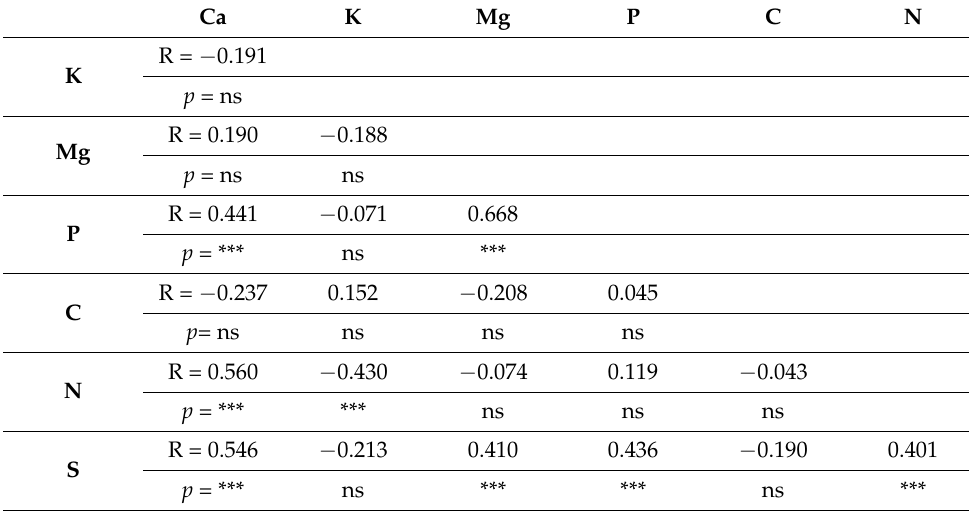
Table 4. Pearson correlation coefficients ( p and R values) between cottonseed minerals in cotton chromosome substitution lines (CS) grown in SC 2013.